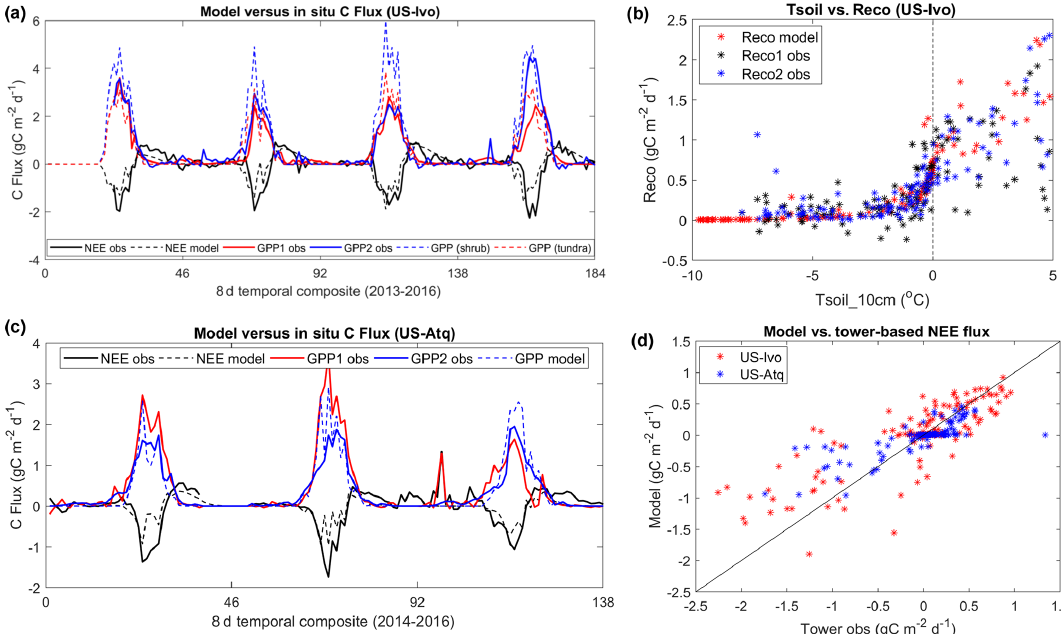
Figure 4. Model-simulated carbon fluxes and temperature sensitivity of ecosystem respiration at two tundra sites (US-Ivo and US-Atq). “GPP1 obs” and “GPP2 obs” represent the gross primary productivity (GPP) estimates derived using tower-based net ecosystem CO 2 ex- change (NEE) measurements and different partitioning methods provided by the tower PI, similar to “Reco1 obs” and “Reco2 obs”. At the US-Ivo site, two GPP simulations were conducted using different maximum light use efficiency (LUE) parameters representing two differ- ent vegetation types (shrub and grassland tundra), indicated as “GPP (shrub)” and “GPP (tundra)” in (a) . Comparisons between model and tower-based NEE fluxes at the two sites are shown in (d)